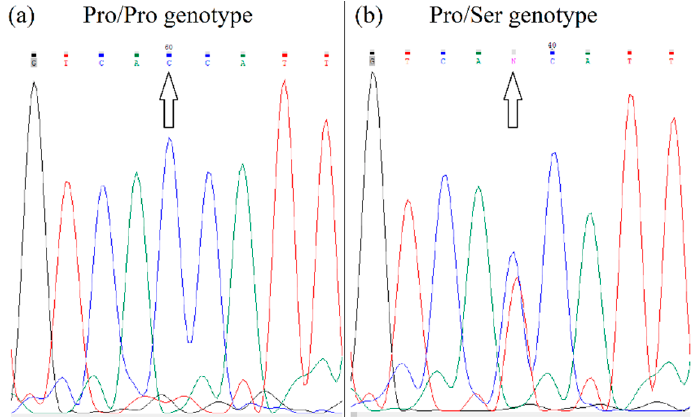
Figure 4. Fluorogram of HIF1A gene sequencing. Figure ( a ) shows the Pro/Pro genotype, since the polymorphic site contains nucleotide C. Figure ( b ) shows the Pro/Ser genotype, because the polymorphic site contains both T and C nucleotides.